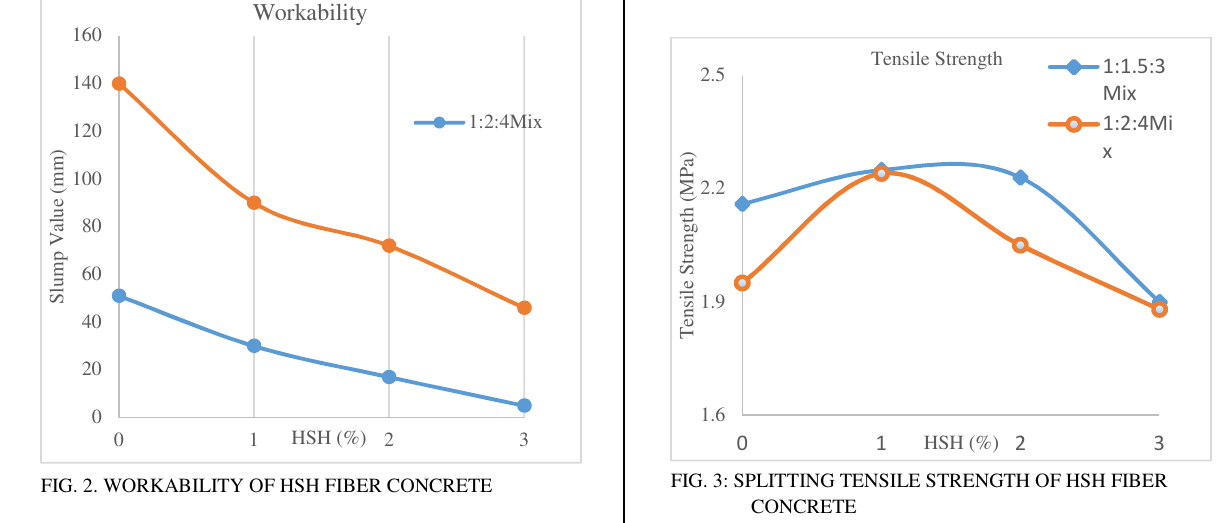
FIG. 2. WORKABILITY OF HSH FIBER CONCRETE FIG. 3: SPLITTING TENSILE STRENGTH OF HSH FIBER